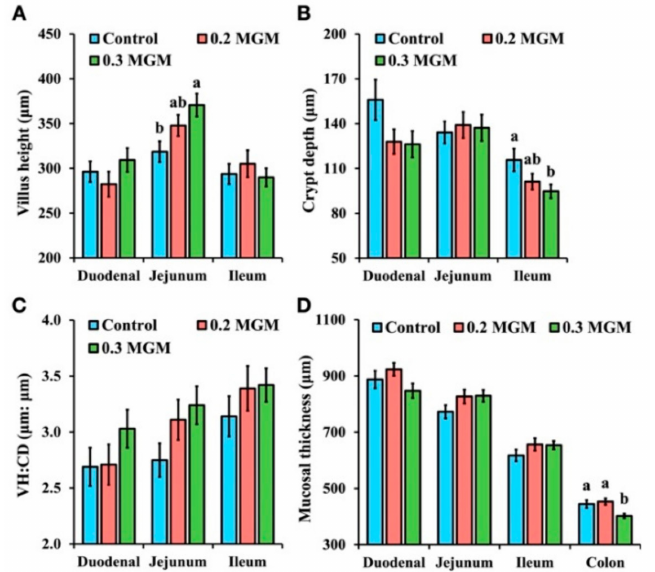
Figure 7. Effects of MGM-P supplementation on the intestinal morphology of weaned piglets. Abbreviations: VH:CD, villus height/crypt depth; Control, control group; 0.2 MGM, 0.2% MGM-P group; 0.3 MGM, 0.3% MGM-P group. Values are expressed as mean ± SEM; n = 4. Different lowercase letters above the bars indicate significant differences ( p < 0.05; Tukey HSD test). ( A ) comparison of villus height in different groups (duodenum, jejunum and ileum); ( B ), comparison of crypt depth in different groups (duodenum, jejunum and ileum); ( C ) the ratio of villus height to crypt depth in different groups (duodenum, jejunum and ileum); ( D ) comparison of mucosal thickness in different groups (duodenum, jejunum, ileum and